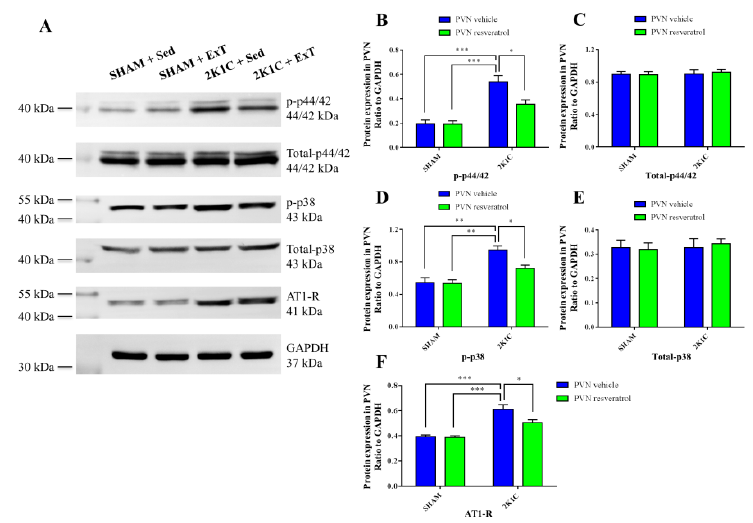
Figure 6. Eight weeks of aerobic ExT attenuated PVN protein expression for p-p44/42 MAPK, p-p38 MAPK, and AT-1R in 2K1C group. ( A ) Representative immunoblots of p-p44/42 MAPK, to- tal-p44/42 MAPK, p-p38 MAPK, total-p38 MAPK and AT-1R. ( B , C ) Densitometry of protein ex- pressions of p-p44/42 MAPK and total-p44/42 MAPK. ( D , E ) Densitometry of protein expressions of p-p38 MAPK and total-p38 MAPK. ( F ) Densitometry of protein expressions of AT-1R. * p < 0.05, ** p < 0.01, *** p < 0.001, n = 3.